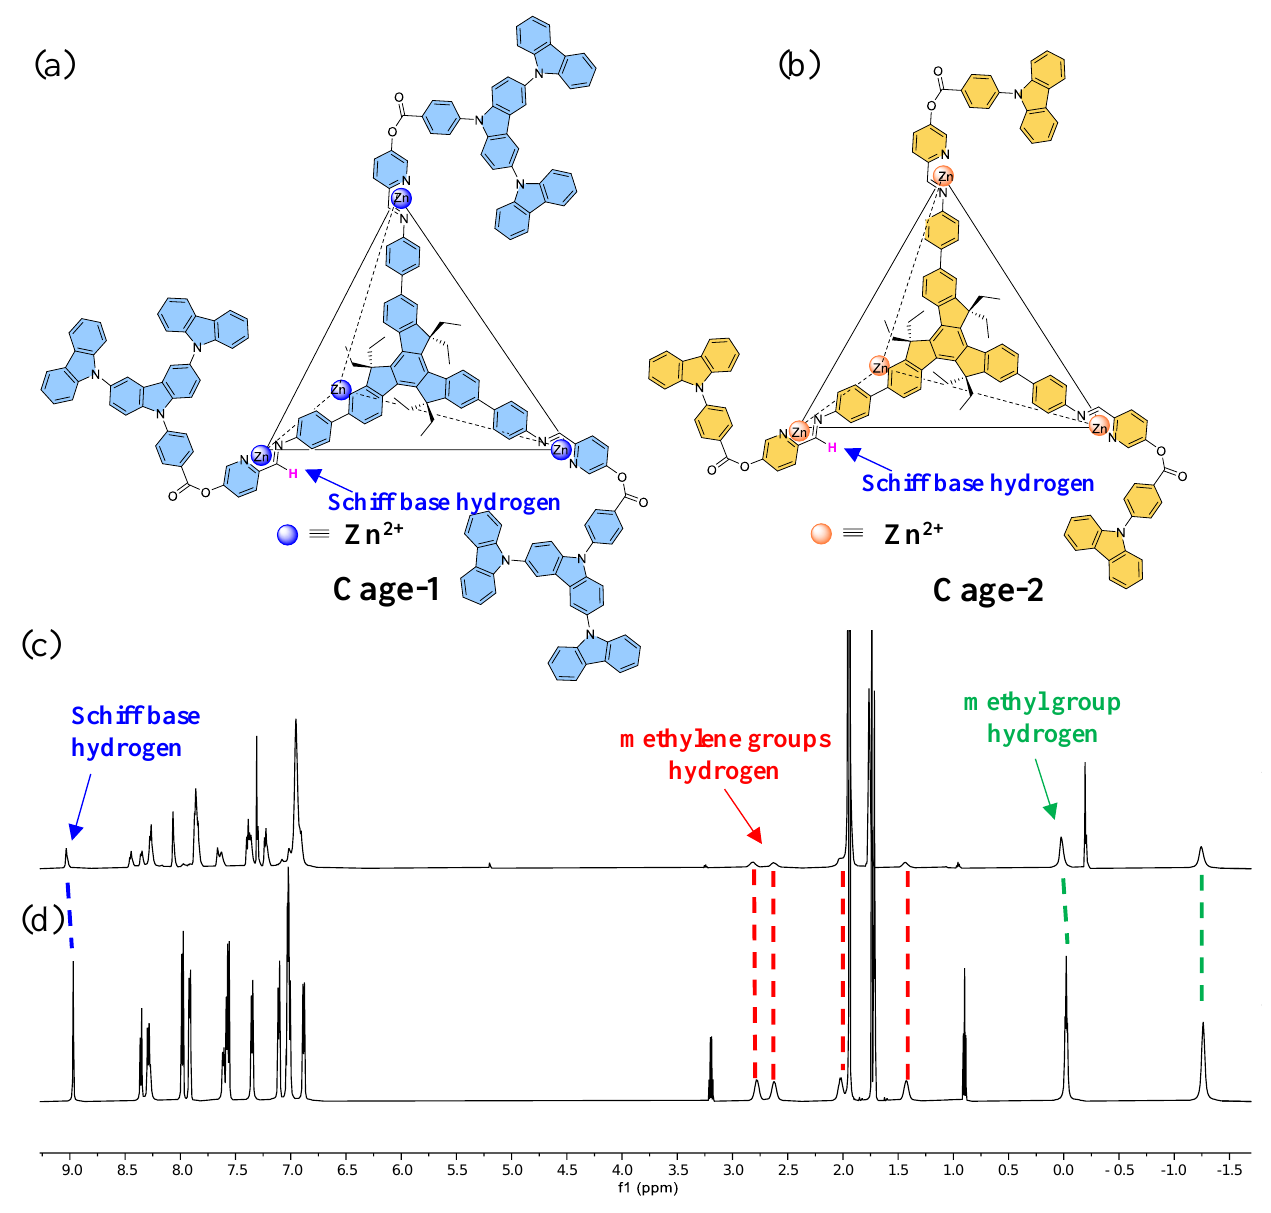
Figure 3. ( a ) The structure of Cage-1 ; ( b ) The structure of Cage-2 ; ( c ) 1 H NMR (CD 3 CN: CDCl 3 = 1:1, 600 MHz, 298 K) spectrum of Cage-1 ; ( d ) 1 H NMR (CD 3 CN, 600 MHz, 298 K) spectrum of Cage-2 . Ligand LB has a solvent effect and aggregation-induced emission enhancement (AIEE) behavior due to its origin in the different solubility of the ligand in diverse solvents and different stacking modes in diverse solvents [50]. Carbazole derivatives are known to show a solvent influence on the difference in fluorescence color and good AIE behavior [38]. Thus, because of the twisted structure of ligand LA, which has a dendritic carbazole arm, it ought to hold a solvent-effect-induced fluorescence variation and AIE behavior as well. Consistent with expectations, similar phenomena were observed for ligand LA: the solvent effect caused spectral variations in its absorbance and fluorescence. Owing to electrons performing n- π* transitions in the large conjugated system, the UV– Vis absorption of ligand LA occurs at 280 – 350 nm (Figure S15a). The fluorescence emission spectra of ligand LA manifested diverse photoluminescence intensity and maximum emission wavelengths in different solvents, such as toluene, EA, chloroform, and 1,4-dioxane (Figure S15b). Additionally, the fluorescence spectra of ligand LA in different ratios of chloroform (desirable solvent) and ethyl ether (undesirable solvent) mixtures were examined.